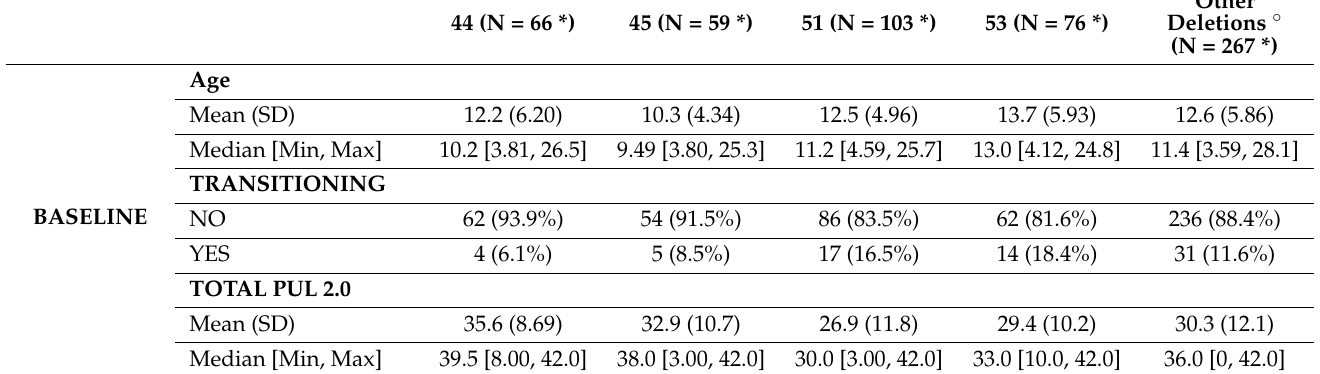
Table 1. 12- and 24-month PUL changes subdivided in exon skip classes. Key to table: ◦ = other deletions not amenable to skipping 44, 45, 51 and 53; * = N represent the number of 24-month paired